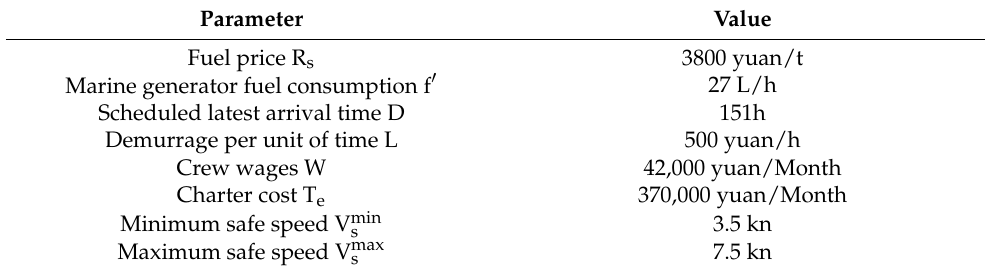
Table 3. Specific parameters. Parameter